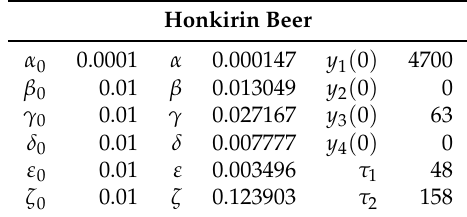
Figure 3. Fitting to “Honkirin” data. Table 3. Various parameter